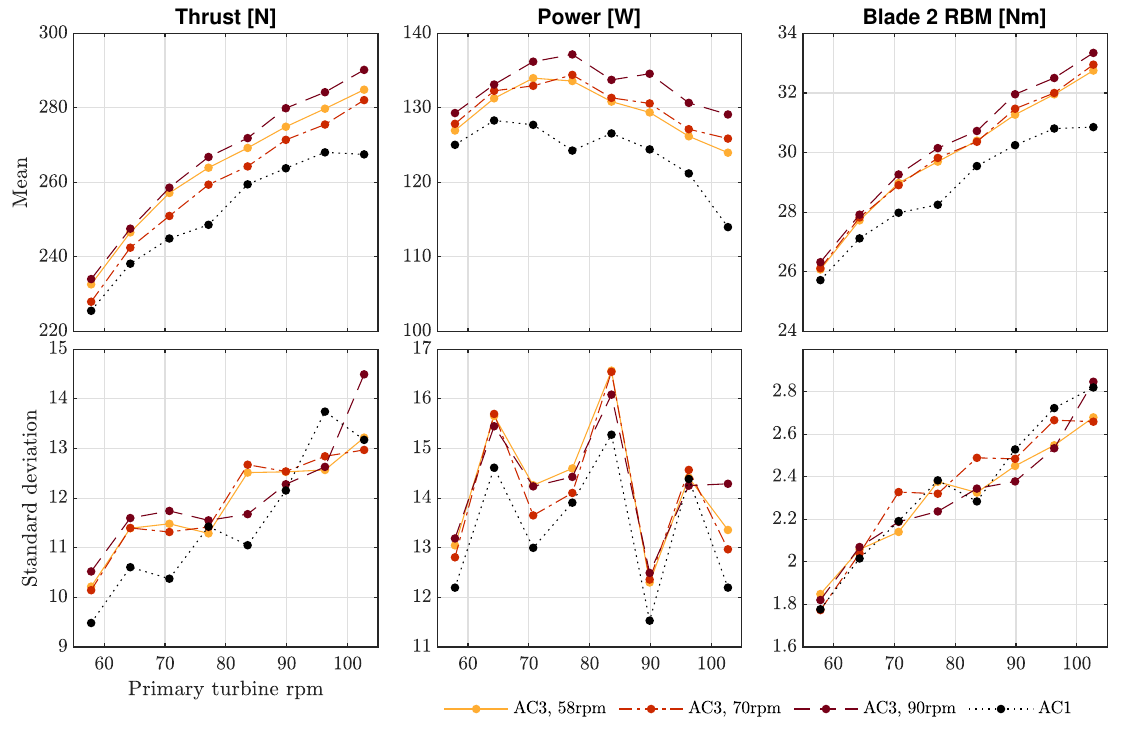
Figure 9. Average and standard deviation of thrust and power of the turbine plus root bending moment of a blade all as a function of rotational speed. Each plot shows these forces/moments for the primary turbine with the front two turbines operating at three different rotational speeds (AC3) and also shows the comparable single turbine case